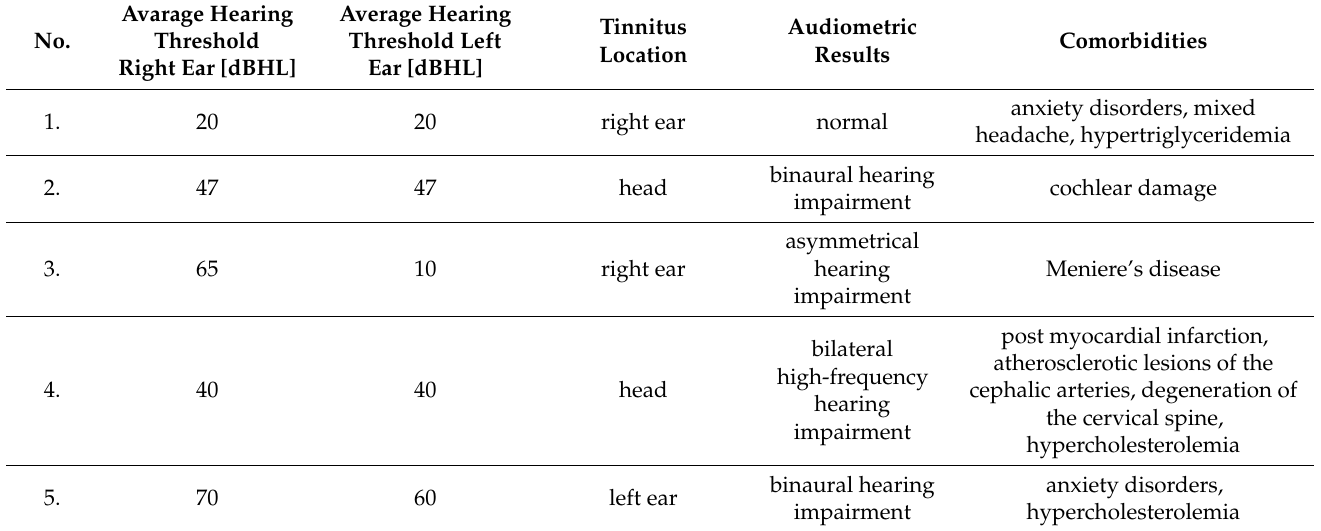
Table 3. Characteristics of the selected audiological parameters and comorbidities in the study